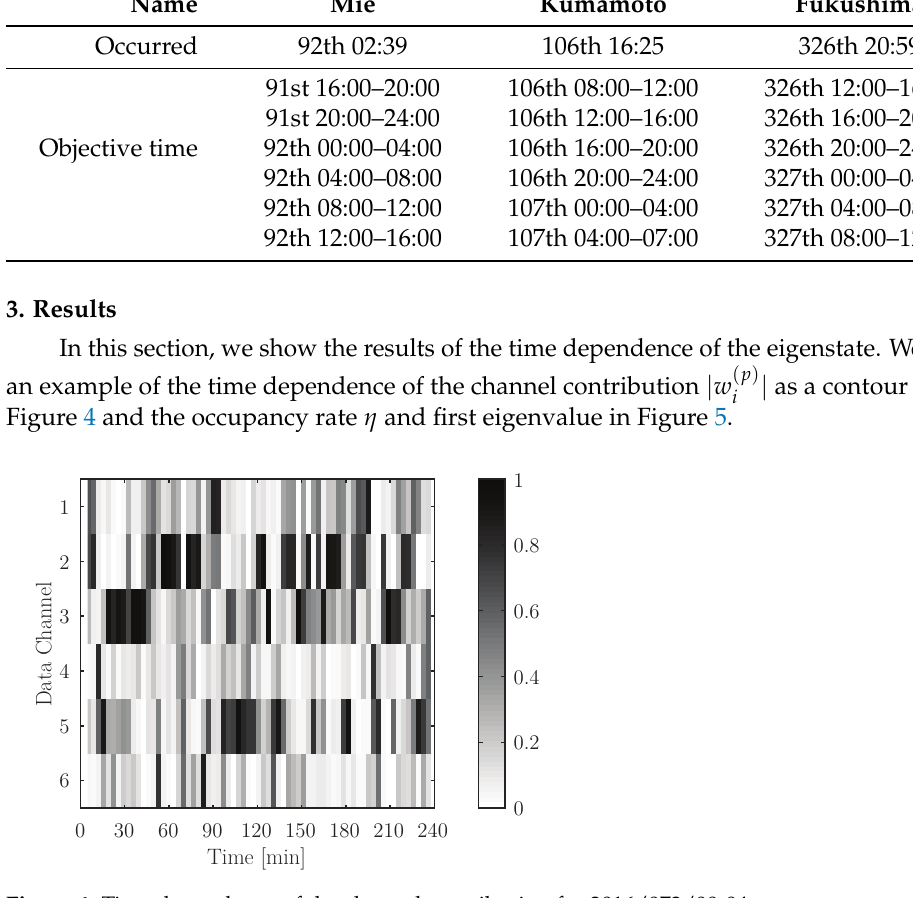
Figure 4. Time dependence of the channel contribution for